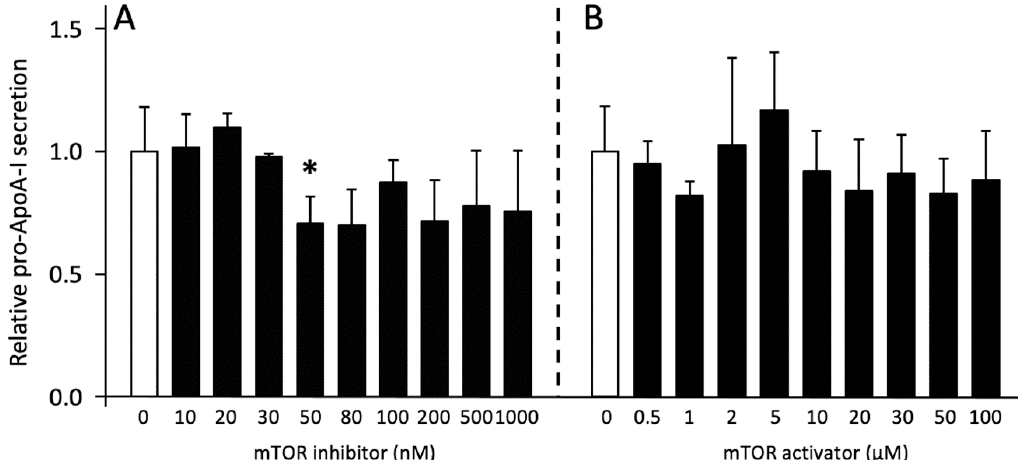
Figure 7. Effects of mTOR inhibition and activation on pro-ApoA-I secretion. HepG2 cells were